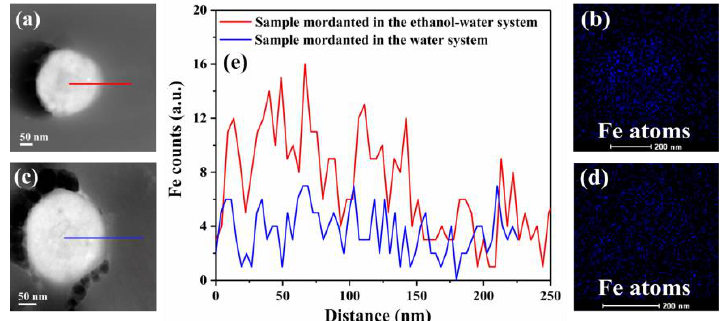
Figure 10. TEM images and EDS elemental mappings. ( a ) TEM images of a melanin granule mordanted in the ethanol–water system; ( b ) EDS elemental mapping of Fe in a melanin granule ( a ); ( c ) TEM images of a melanin granule mordanted in the water system; ( d ) EDS elemental mapping of Fe in a melanin granule ( c ); ( e ) EDS line scan profiles of Fe recorded along the line shown in ( a,c ).